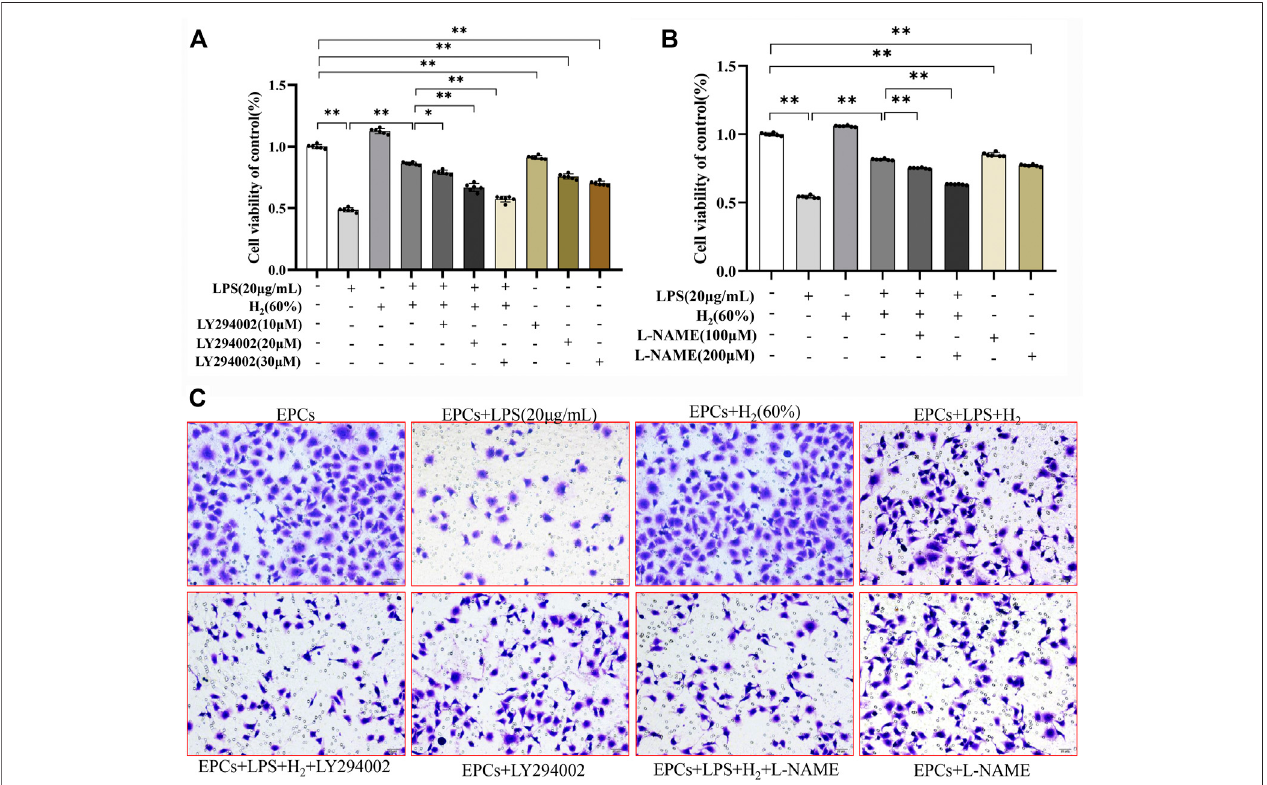
FIGURE 4 | LY294002 and L-NAME inhibited the H 2 -induced repair of EPCs dysfunctions damaged by LPS. EPCs were treated with the PI3K inhibitor LY294002 (10 μ M, 20 μ M, 30 μ M) or the eNOS inhibitor L-NAME (100 μ M, 200 μ M), incubated with LPS (20 μ g/ml) and H 2 (60%) for 72 h. The viability of EPCs was assessed by MTT assay (A,B) , n = 6). EPCs migration was measured by transwell assay (C,D) n = 15. Tube formation was measured by Tube formation assay (E,F) n = 15. Data are presented as mean ± SD; * p < 0.05 and ** p <